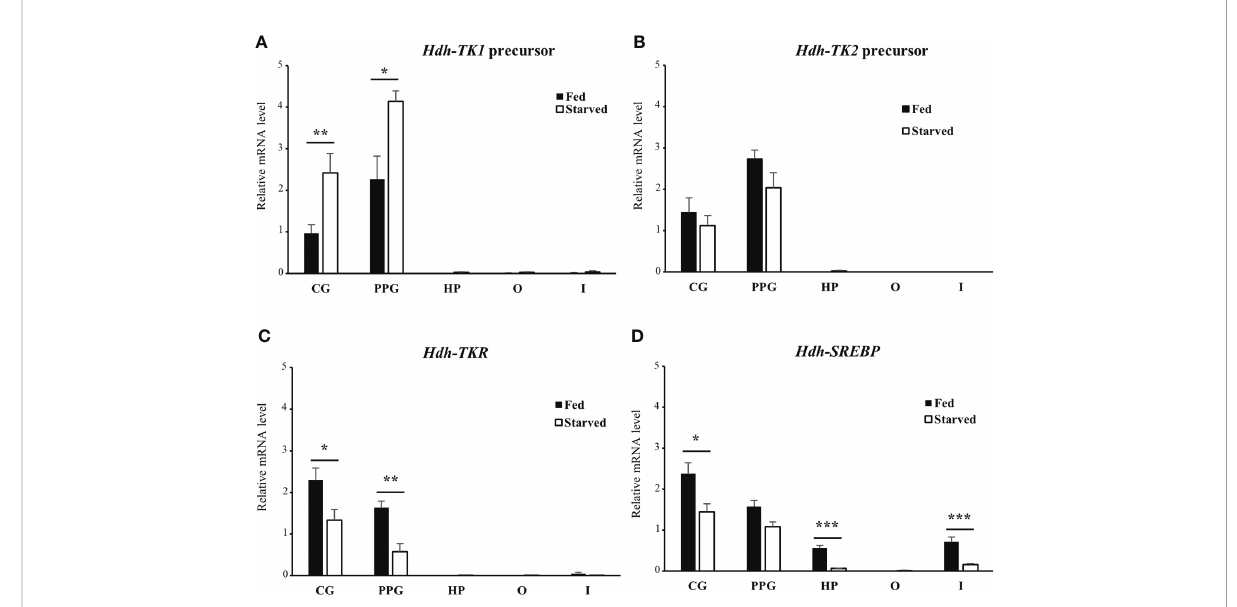
FIGURE 10 Relative transcript levels of (A) Hdh-TK1 and (B) Hdh-TK2 precursors, (C) Hdh-TKR, and (D) Hdh-SREBP in various tissues from fed or starved abalone for 3 weeks. Relative transcript levels were measured by real-time quantitative PCR. The ribosomal protein L-5 ( Hdh-RPL5 ) was used as the internal control. All data represent the mean ± SEM (n = 6). Statistical signi fi cance was tested by Student ’ s t-test. *p < 0.05, **p < 0.01, ***p < 0.001. CG, cerebral ganglion; PPG, pleuro-pedal ganglion; HP, hepatopancreas; O, ovary; I,